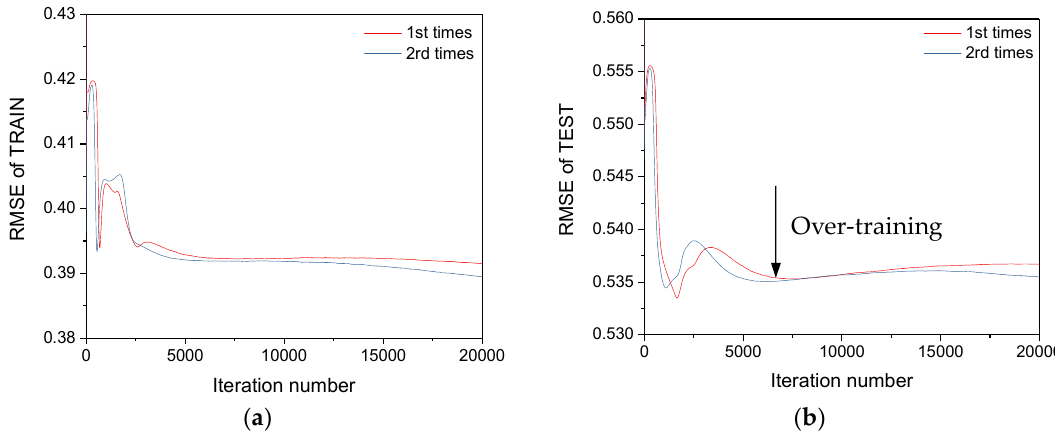
Figure 19. The RMSE of the training and testing groups: ( a ) the RMSE of training; ( b ) the RMSE of testing.